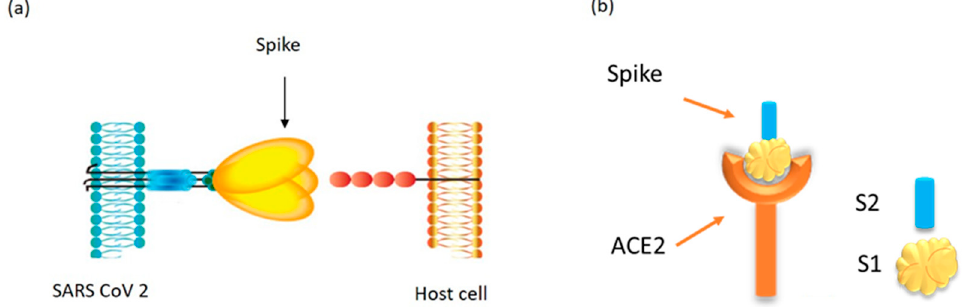
Figure 1. Schematic illustration of the SARS-CoV-2 spike protein and ACE2 receptor binding. ( a ) SARS-CoV-2 binding to the ACE2 receptor on the host cell surface. ( b ) Binding of ACE2 and the spike protein along with an illustration of the spike protein subunits, S1 and S2.